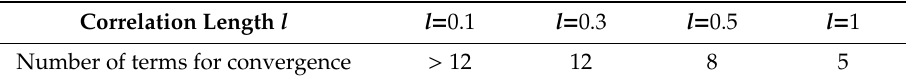
Figure 5. Comparing Eigenvalues convergence rate for l = 0.1 and l = 0.3. Table 3. PCE vs. MC solution